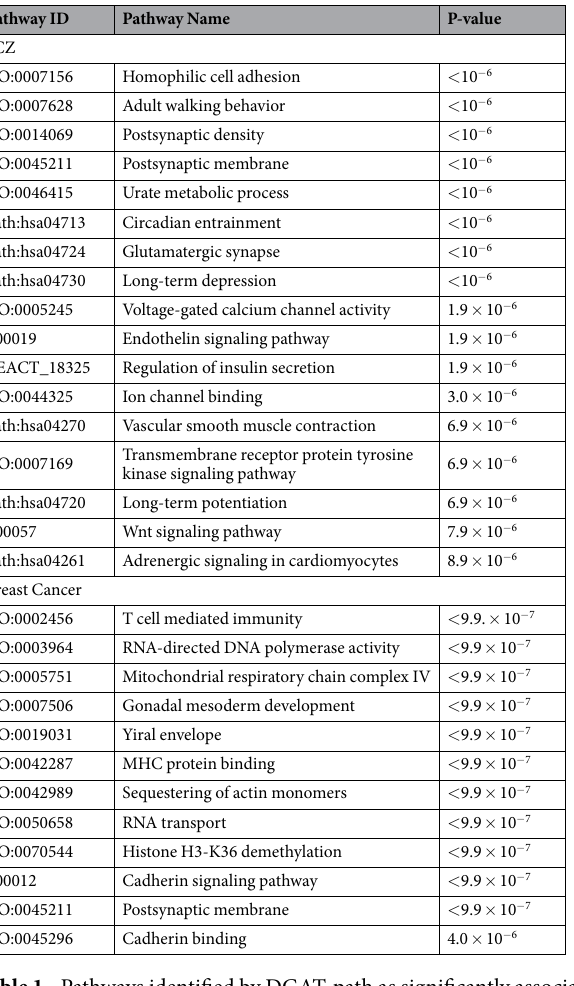
Table 1. Pathways identified by DGAT-path as significantly associated with SCZ and Breast